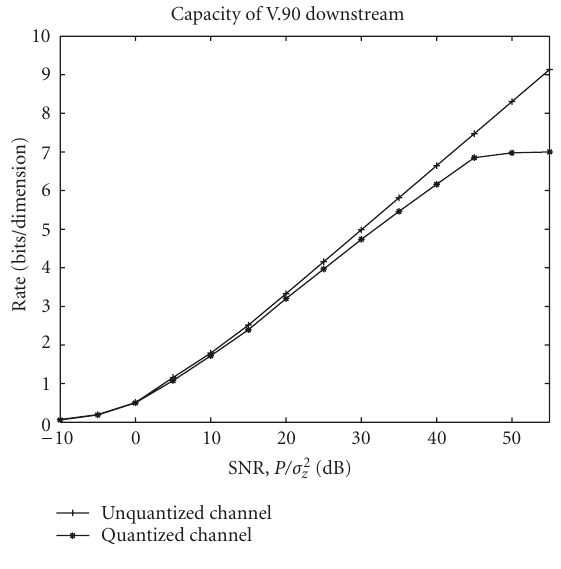
Figure 14: Capacity of the downstream